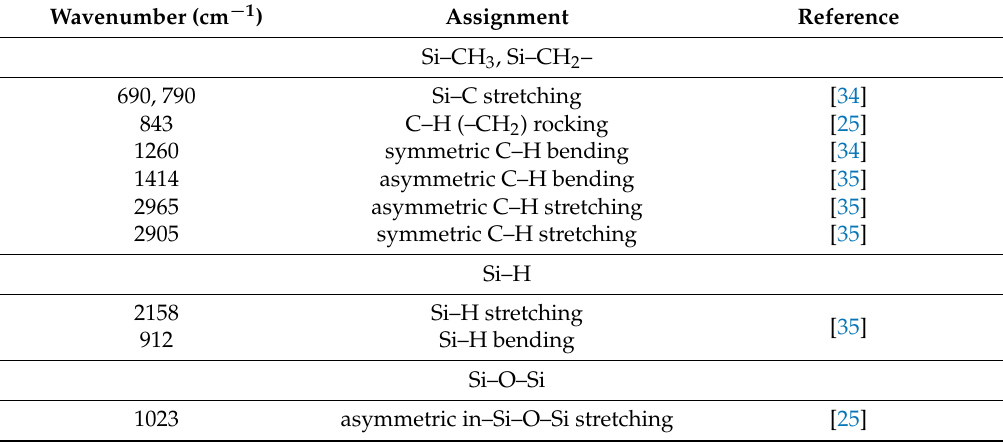
Figure 2. ( a ) A 3D ‐ porous PDMS foam obtained through a sugar ‐ based template approach and its swelling behaviour in ethanol and hexane. ATR ‐ FTIR spectra of hexane ( b ) and ethanol ( c ) cleaning solvents, acquired during the cleaning procedure setup for both bulk PDMS and 3D ‐ porous PDMS foam. Table 1. Assignments of the main FTIR absorption bands of silicon ‐ based materials.